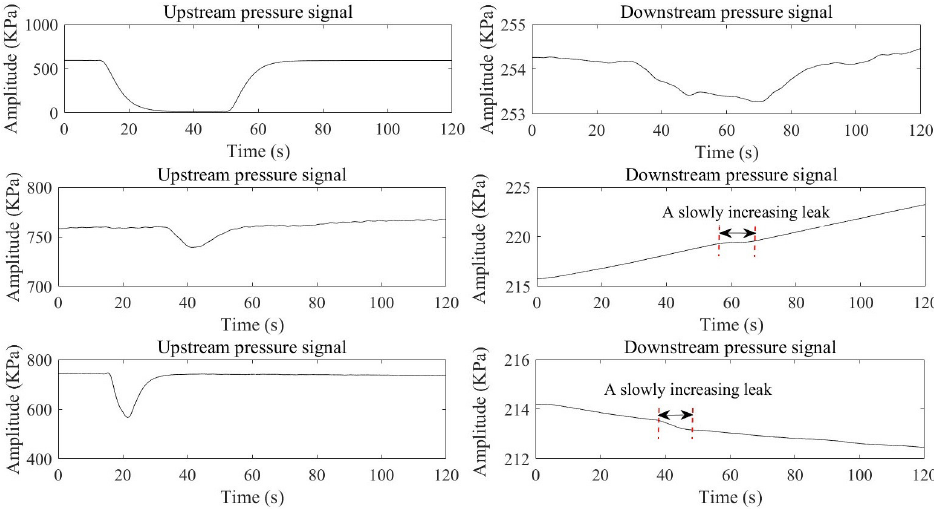
Figure 1. Typical slowly increasing leak